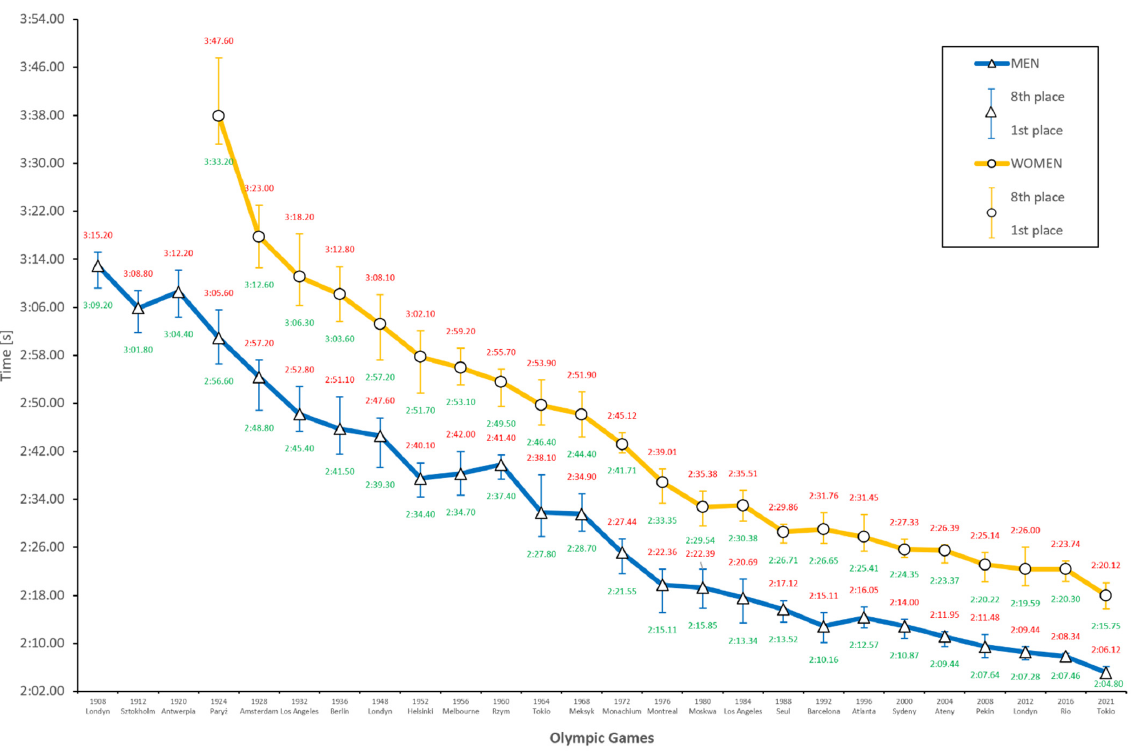
Figure 2. Men’s and women’s 200 m breaststroke results during the last 25 Olympic Games and prediction for Tokyo 2021.